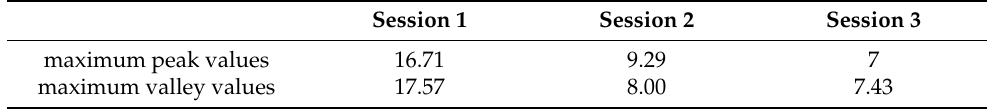
Figure 7. Kruskal–Wallis test for forward bending. The notch in session 3 does not have overlap with the notch in session 1, which means that it has a different median (Q2/50th Percentile) at the 5% significance level. Q1 has a decreasing trend over the 3 sessions. Q3 is not decreasing consistently along the 3 sessions. Table 7. Mean ranks for forward/backward bending in